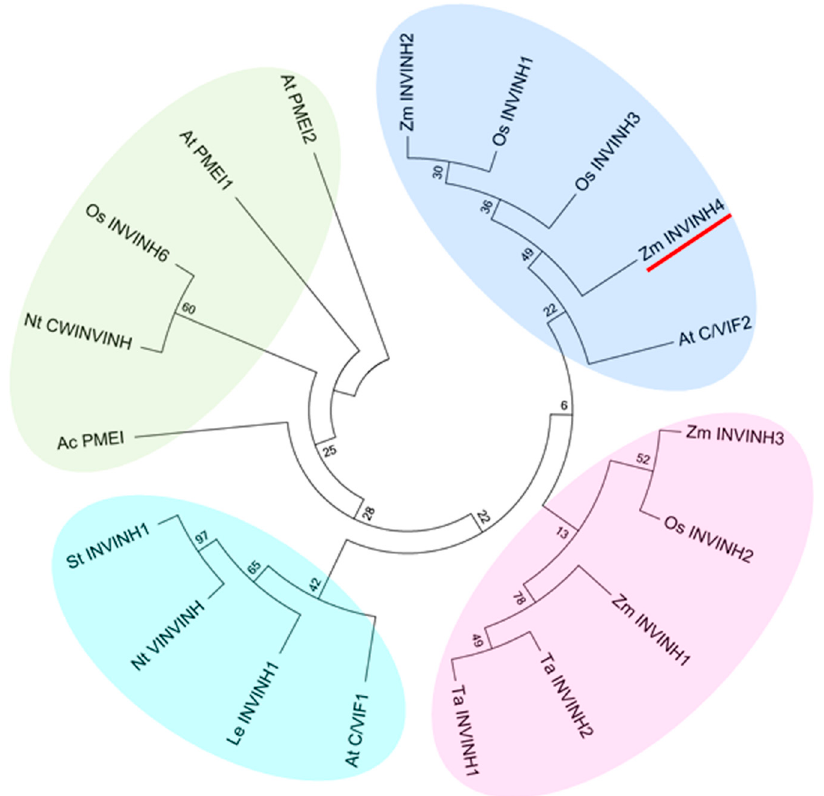
Figure 2. Phylogenetic analysis of invertase inhibitors of plants based on the predicted amino acid sequences. Four groups can be discerned. Bootstrap values (%) are indicated for major branches. Zm-INVINH4 was marked with red line. Abbreviations for the species are: Actinidia deliciosa ( Ac); Arabidopsis thaliana ( At); Coffea canephora ( Cc); Nicotiana tabacum ( Nt); Lycopersicum esculentum ( Le); Oryza sativa ( Os); Solanum tuberosum ( St); Triticum aestivum ( Ta); Zea mays ( Zm).